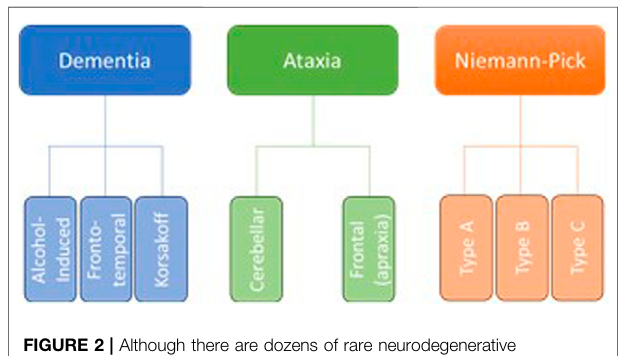
FIGURE 2 | Although there are dozens of rare neurodegenerative disorders,wehavechosentofocusonthoseinwhichtheetiologysuggestsan increased susceptibility to the effects of alcohol abuse, as well as those in whichatleastsomeresearchhasbeendone tosuggestadirecteffectof alcohol on